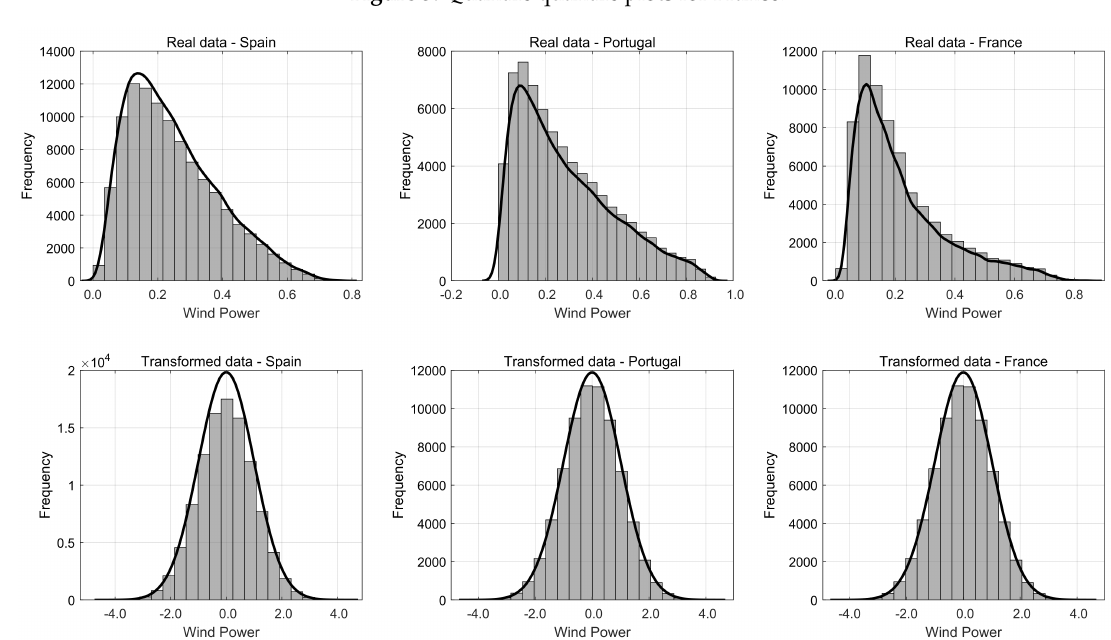
Figure 3. Quantile quantile plots for France.